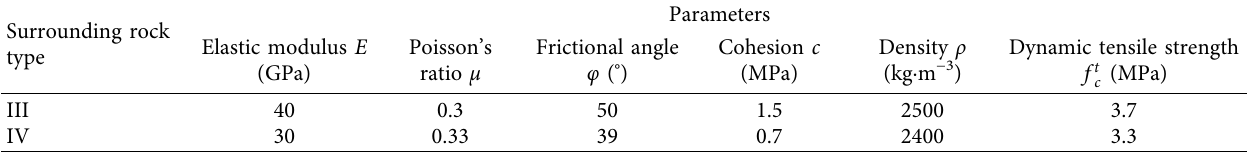
Table 7: Physical and mechanical parameters of the surrounding rock.